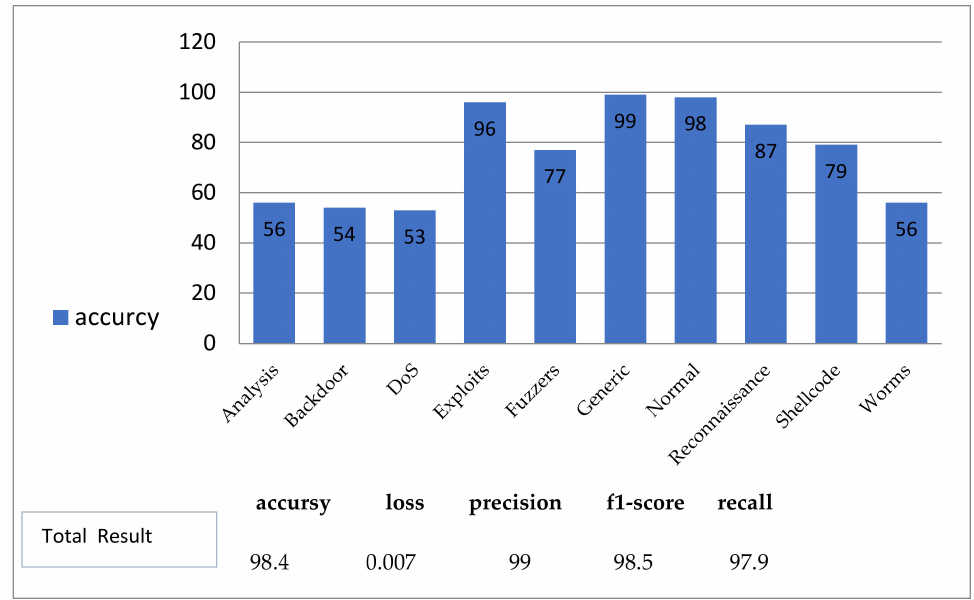
Figure 14. The Inception Time and multi-class results for the UNSW-NB15 dataset.